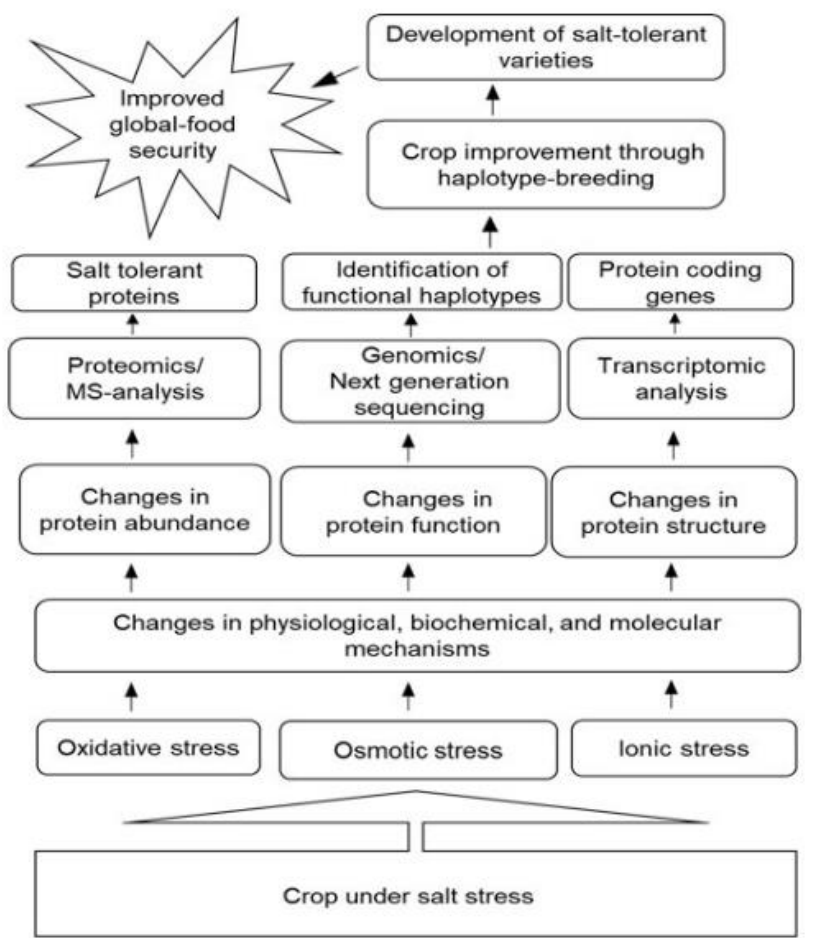
Figure 4. Integration of different omics techniques for crop improvement under salt stress conditions. A crop under salt stress faces oxidative, ionic, and osmotic stresses all together, which ultimately leads to changes in the physio-biochemical and molecular processes. These changes alter the structure, function, and abundance of proteins, which are the key players in cellular metabolism. The omics revolution has now made it possible to thoroughly study proteins and genes. Advanced genomics techniques allow the identification of candidate SNPs using NGS, followed by the identification of the closely linked adjacent SNPs within a specific range on the same chromosomal region (haplotype). Functional haplotypes can be used as an alternative breeding strategy for developing salt-tolerant crop varieties in a short span of time with a more targeted approach. Abbreviations: NGS, next-generation sequencing; SNPs, single-nucleotide polymorphisms.